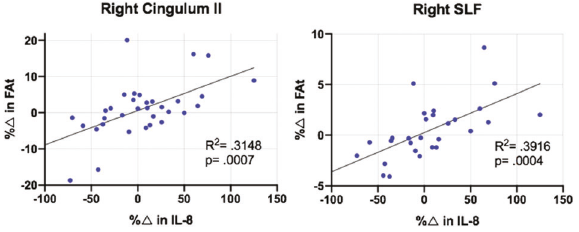
Fig. 3 Correlations between FAt and IL-8. Correlations between percent change in FAt & IL-8 from time point 1 (pre-ECT) to time point 2 (immediately following ECT treatment) in R Cing II and